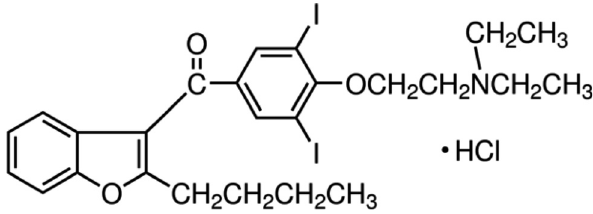
Figure 1: Chemical structure of amiodarone